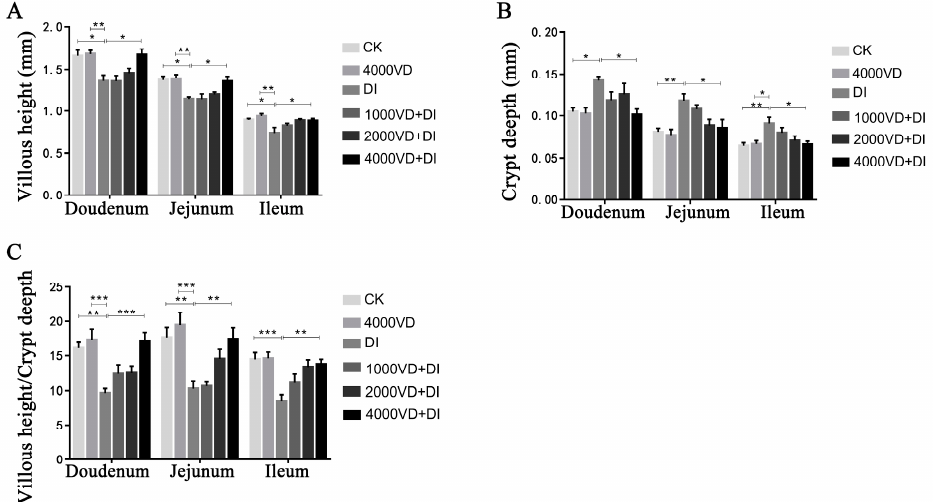
Figure 4. The villous height, crypt depth, and villous height/crypt depth. ( A ) the villous height of each intestinal segment. ( B ) the crypt depth of each intestinal segment. ( C ) the villous height/ crypt depth of each intestinal segment. (Statistical analysis of the data was performed using the Duncan method to analyze the significance of differences between samples by IBM SPSS software, * p < 0.05, ** p < 0.01, *** p < 0.001).